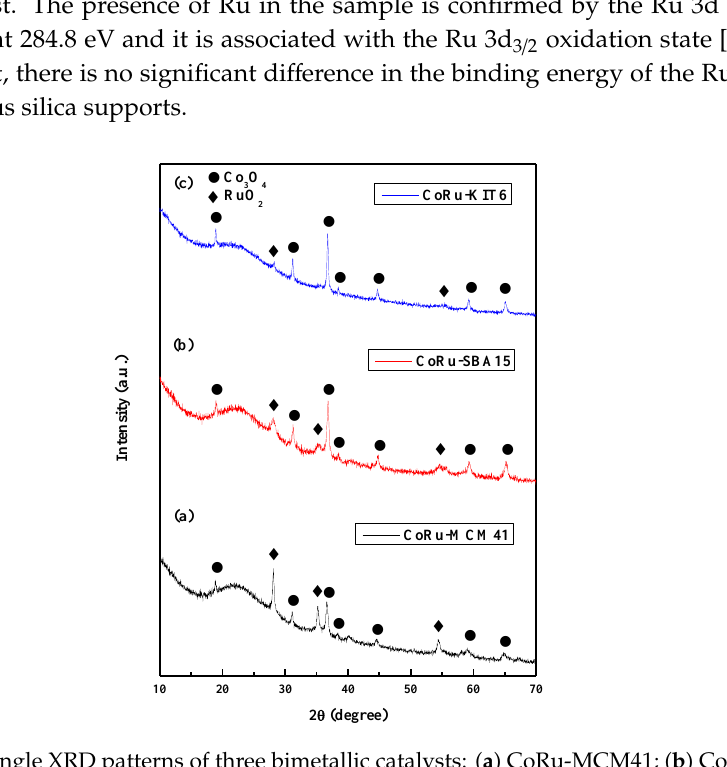
Figure 4. Wide angle XRD patterns of three bimetallic catalysts: ( a ) CoRu-MCM41; ( b ) CoRu-SBA15; ( c ) CoRu-KIT6.